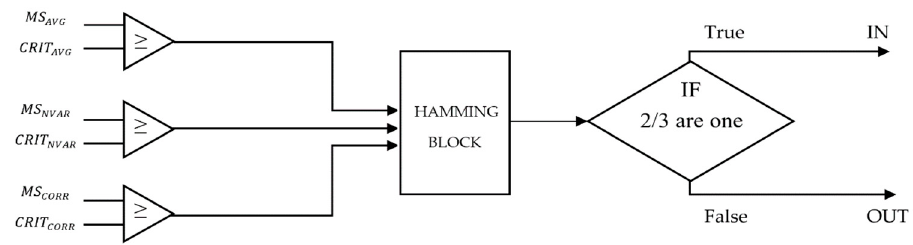
Figure 13. Block diagram of the critic threshold based on the classification algorithm.